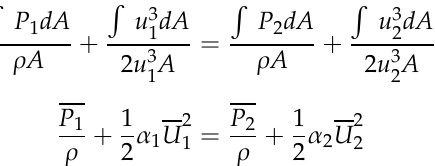
Figure 2. Control volume of an upstream and downstream fence.